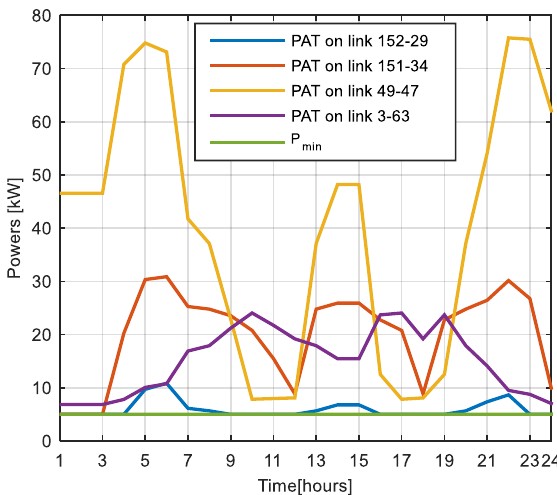
Figure 10. Profiles of hourly powers for four PATs.